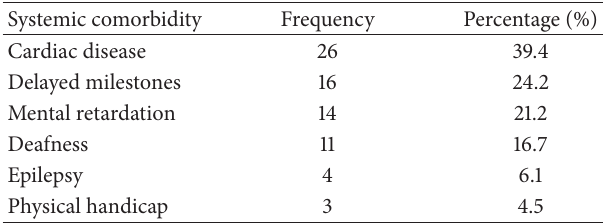
Table 1: Types and frequency of occurrence of systemic comorbidi- ties in children with